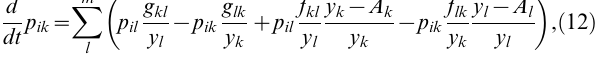
Algorithm 1. The PMMH sampler targeting p ( h , x 1 : T D G 1 : T